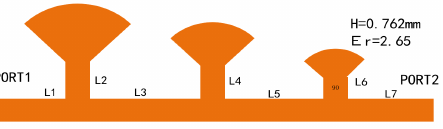
Figure 3. Structure diagram of the three-band